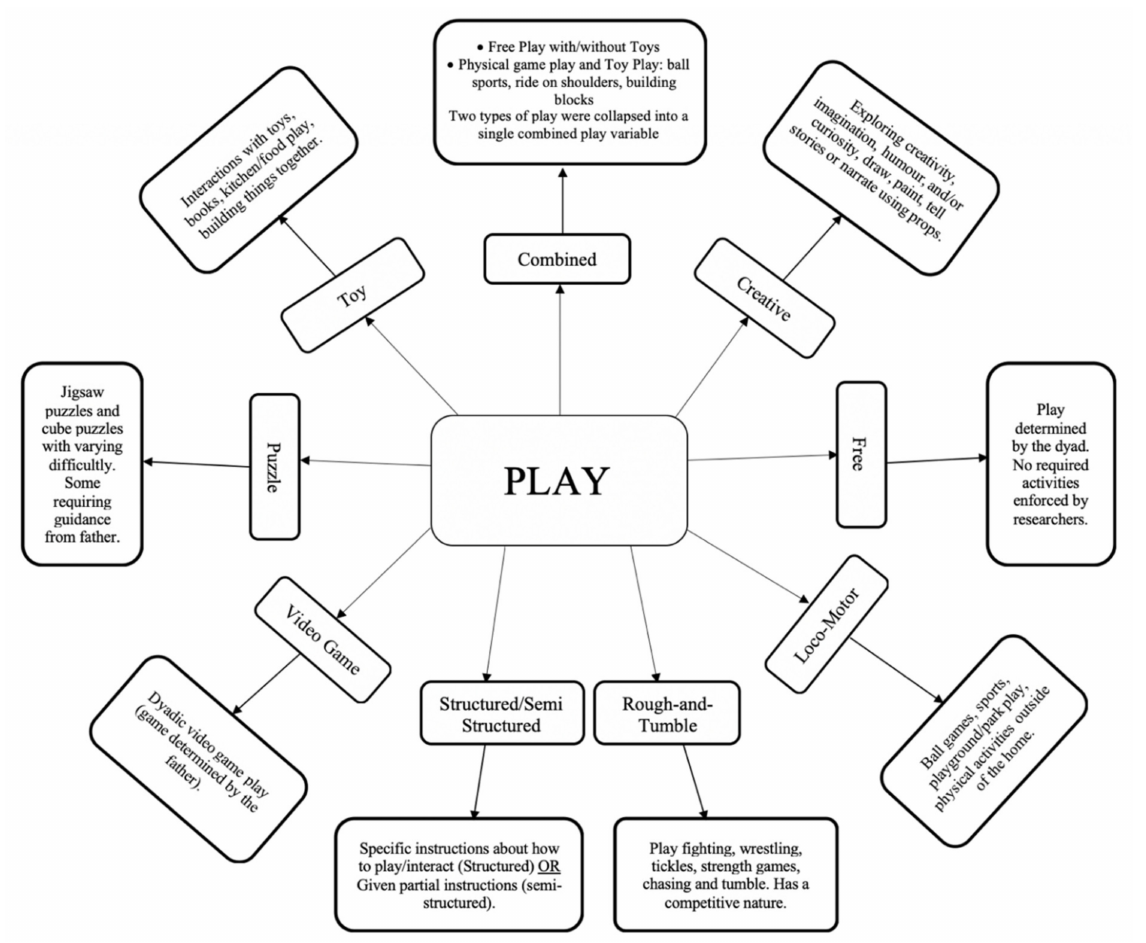
Figure 2. Flowchart providing a brief overview of the various activities found within each play